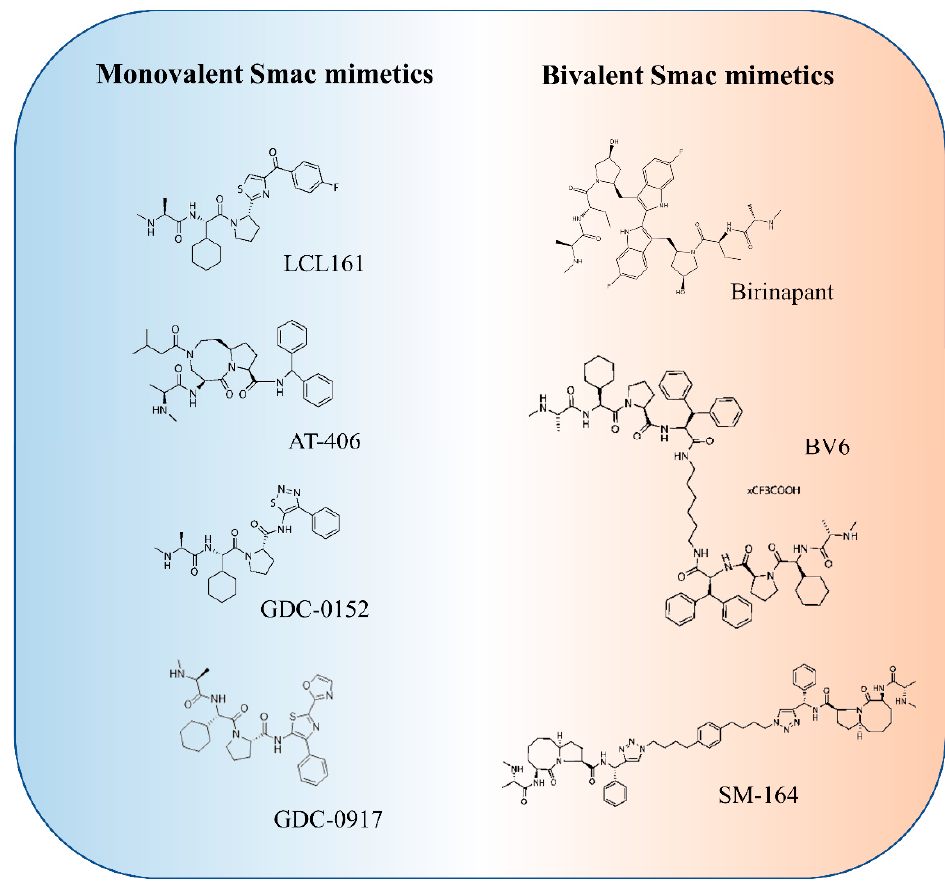
Figure 2. Chemical structure of Smac mimetics for cancer treatment. BV6 was modified with trifluoroacetic acid (xCF3COOH) to improve the solubility of BV6 to DMSO and water.